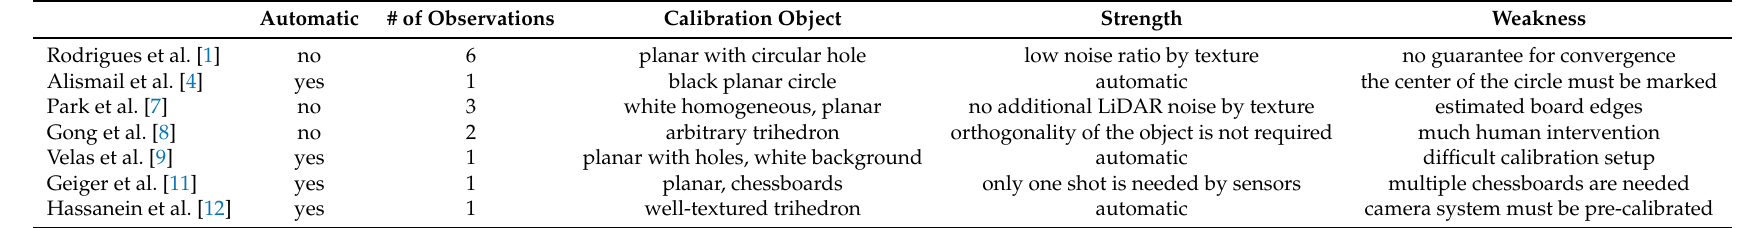
Table 1. This table summarizes the previous works for LiDAR and camera calibration. Their strengths and weaknesses are also